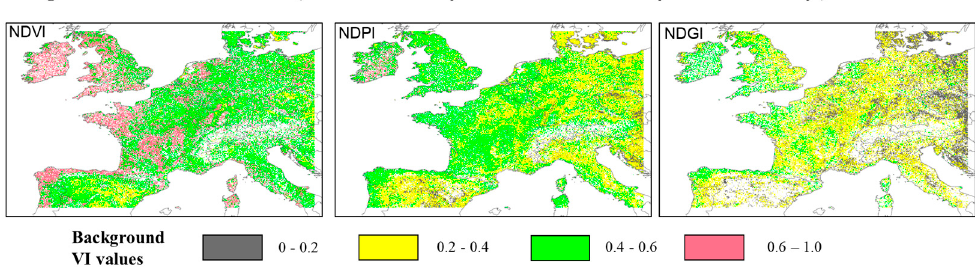
Figure 11. The values of the three indices before GUD (referred to as background value) for the years with GUD uncertainty smaller than three days.